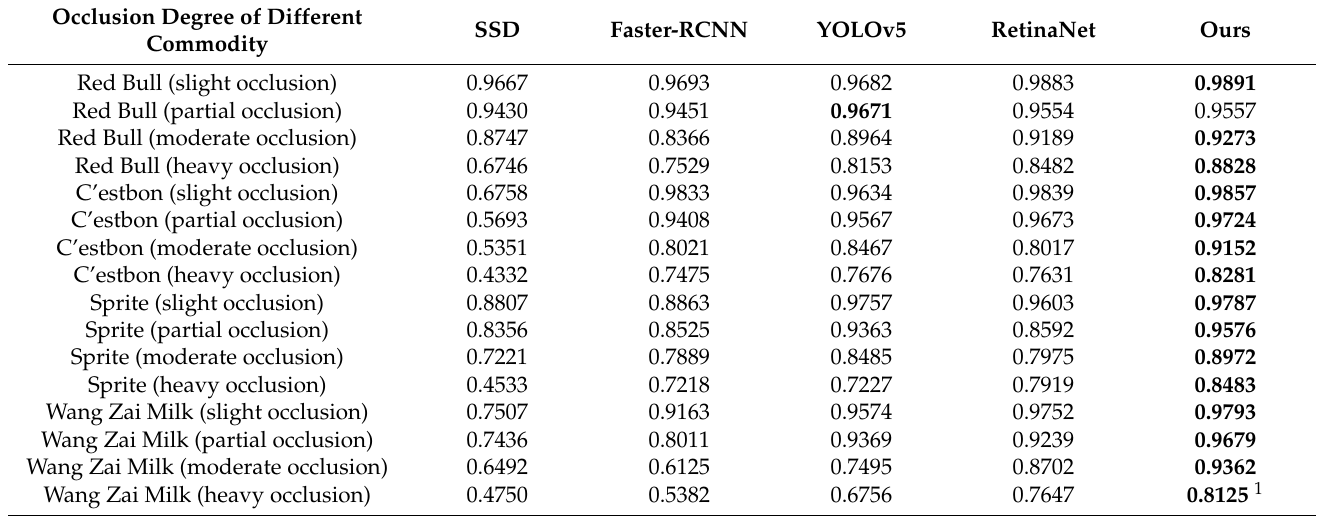
Table 3. Comparison of detection performance of different algorithm